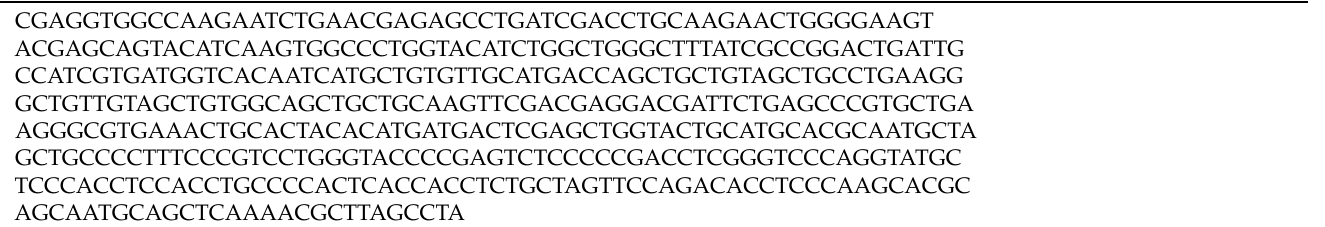
Table 2. Sanger sequencing result of the BNT162b2